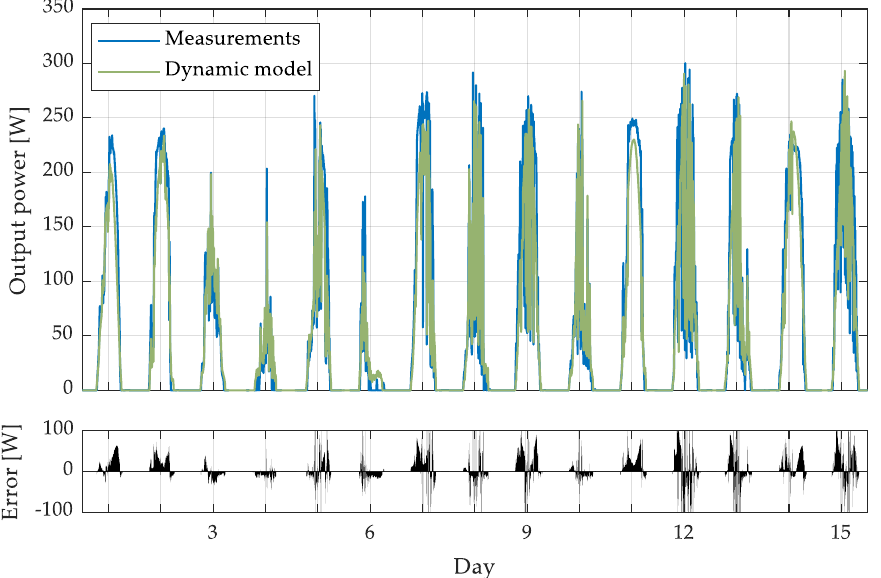
Figure 8. Validation of the dynamic electric model (Matlab/Simulink-double diode model) with experimental data (for 15 days in March 2021).